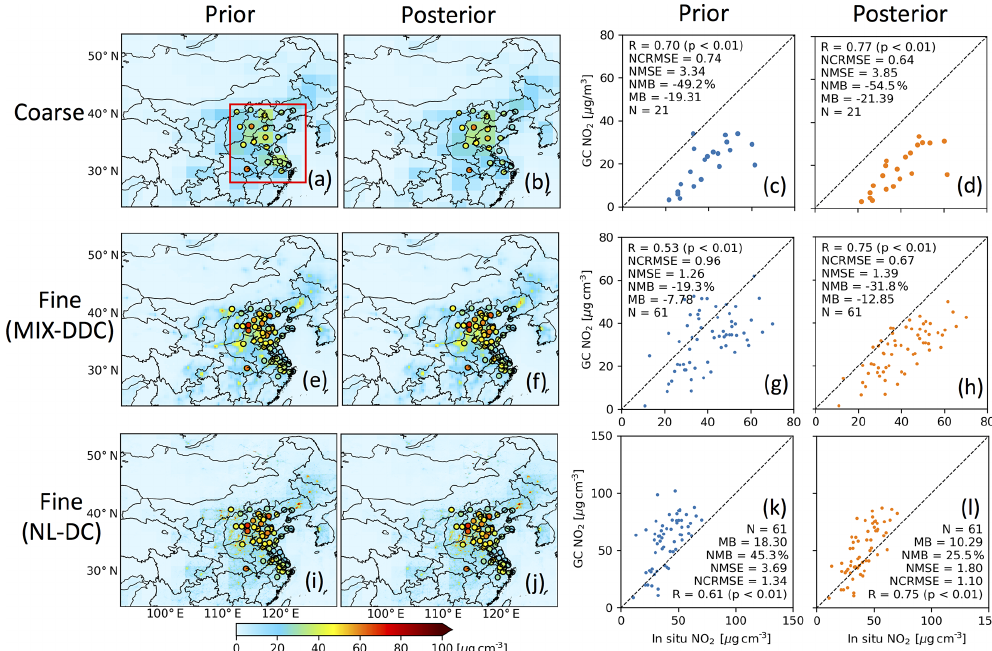
Figure 5. Evaluation of coarse-resolution, MIX-DDC, and NL-DC GEOS-Chem surface NO 2 simulations with in situ observations for October 2013. Panels (a) and (b) show C-PRI and C-POS simulations, respectively, with in situ observations overlapped. If there is more than one observation in a 2 ◦ × 2 . 5 ◦ grid cell, they are averaged. Panels (c) and (d) show scatter plots of C-PRI and C-POS simulations versus in situ observations, respectively. Panels (e) and (f) show GEOS-Chem surface NO 2 of MIX-DDC-PRI and MIX-DDC-POS, respectively, with in situ observations overlapped. Panels (g) and (h) show scatter plots of MIX-DDC-PRI and MIX-DDC-POS simulations versus in situ observations, respectively. Panels (i) – (l) are similar to (e) – (h) , respectively, but results are downscaled through the NL-DC approach (NL- DC-PRI and NL-DC-POS). The linear correlation coefficient ( R ), normalized centered root mean squared error (NCRMSE), normalized mean squared error (NMSE), normalized mean bias (NMB), mean bias (MB), and number of observations ( N ) are shown over scatter plots. As NO x emission is mainly over the North China Plain and eastern China, validation with in situ surface NO 2 is conducted at these areas (red box in a